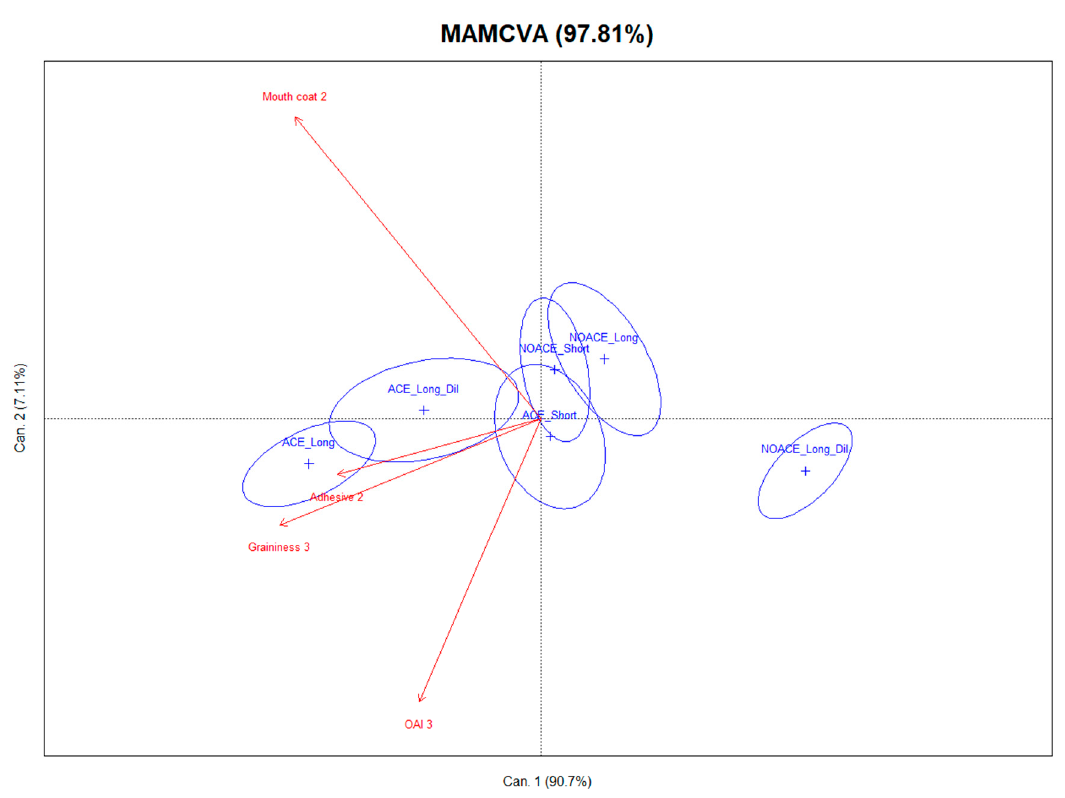
Figure 6. The mixed assessor model canonical variate analysis (MAM-CVA) of six treatments for all significantly different sensory attributes ( p < 0.05) from five evaluation periods. Shiraz wines prepared following the NOACE and ACE maceration with either 3 days (Short) or 6 days (Long) on skins, or 6 days on skins with pre-fermentation water dilution to 13.5 Bé (Long_Dil). Hotelling Lawley stat = 4.458, F = 6.711 ( p ≤ 0.001). Ellipses indicate the confidence intervals of 90%.